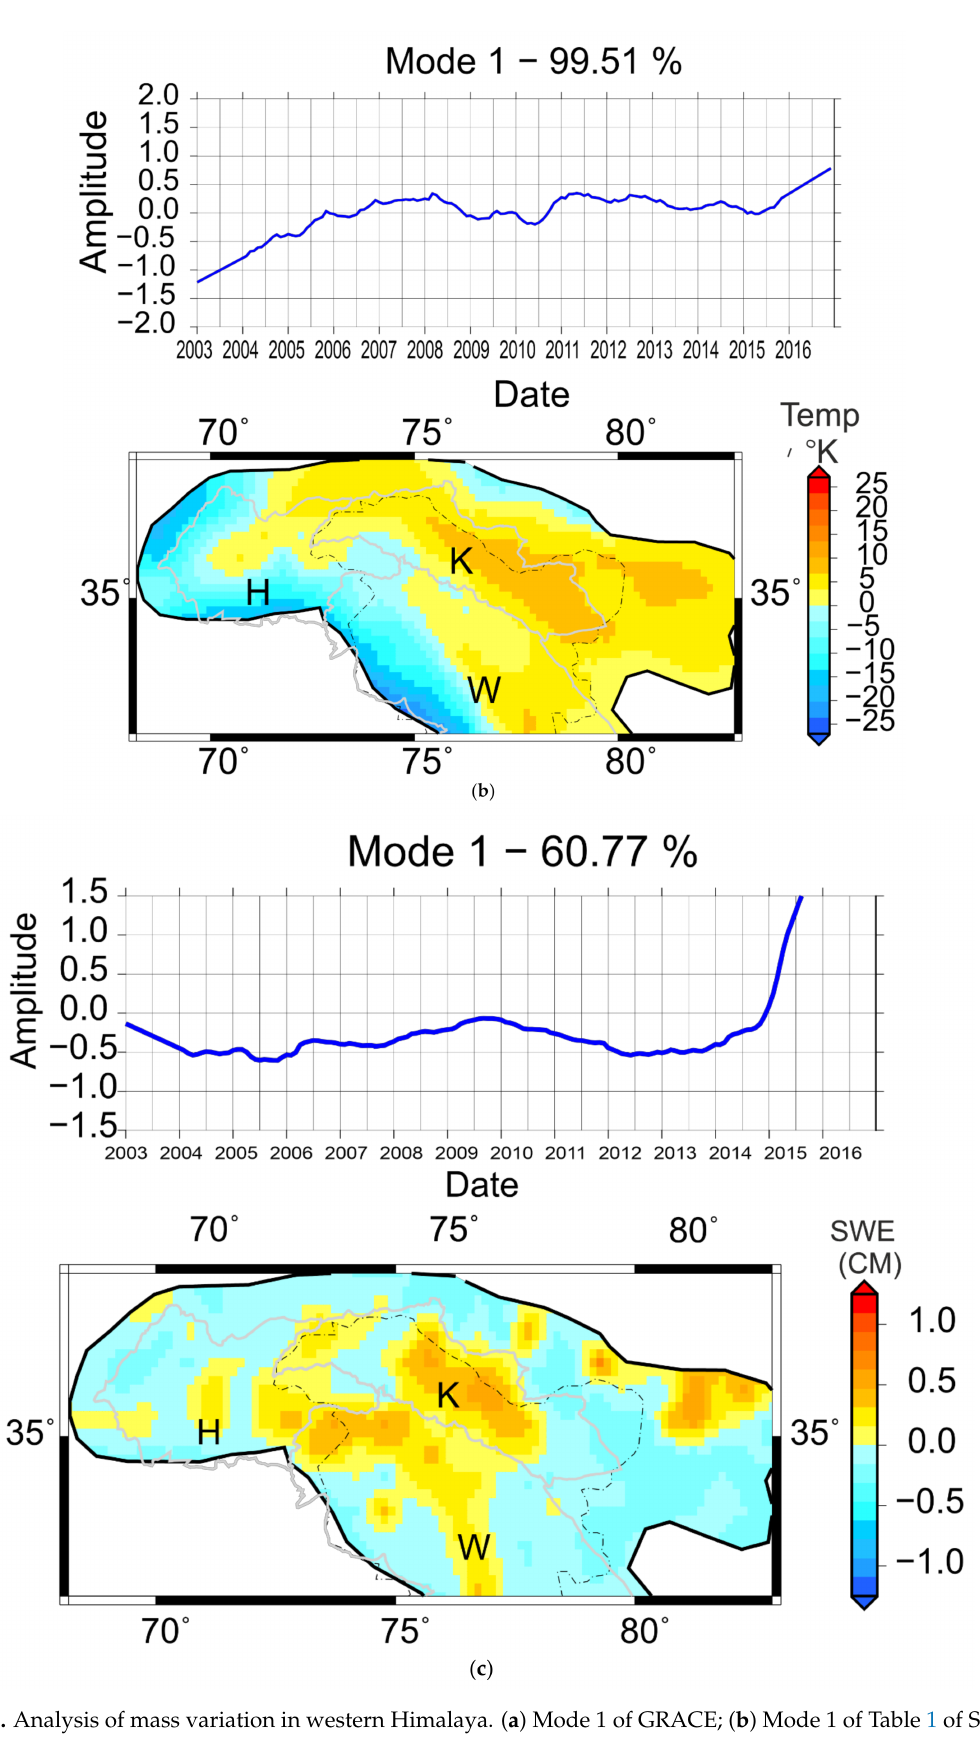
Figure 6. Analysis of mass variation in western Himalaya. ( a ) Mode 1 of GRACE; ( b ) Mode 1 of Table 1 of SWE ( c